Question: Provide a publication-style caption for this figure.
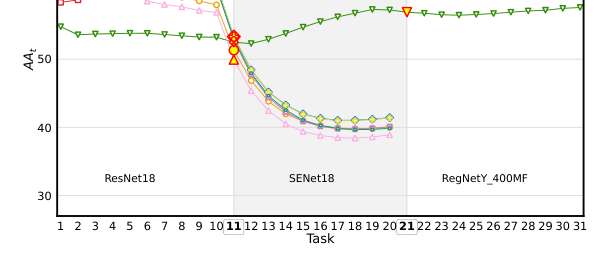
Answer: Plots of Average multi-model Accuracy (AAt) for 31 tasks on CIFAR100R/10, showing the impact of model replace- ments with different network architectures at tasks 11 and 21.